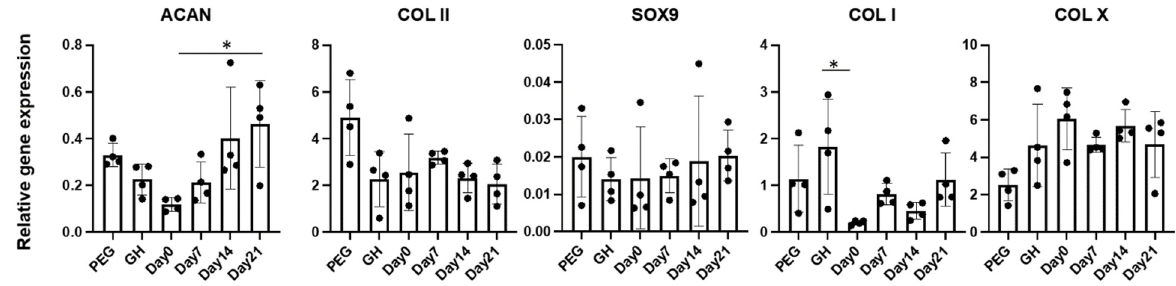
Figure 3. Relative expression levels of selected genes. Data was normalized to the housekeeping gene GAPDH (set as 1) (n = 4 cartilage tissues). * p < 0.05.